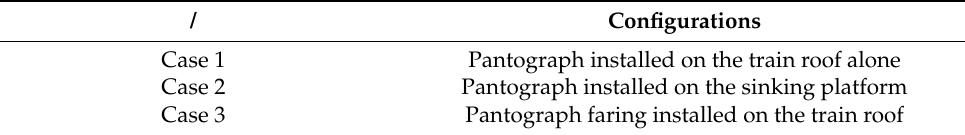
Figure 7. Sketch of the computational models. ( a ) Case 1; ( b ) case 2; ( c ) case 3. Table 2. Three configurations and their so-called names. / Configurations Case